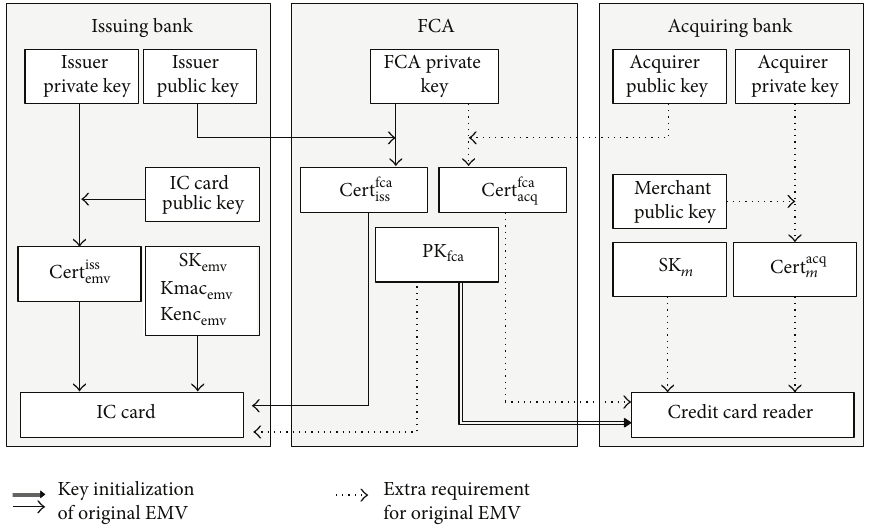
Figure 2: Key initialization of cards and card readers in our scheme.